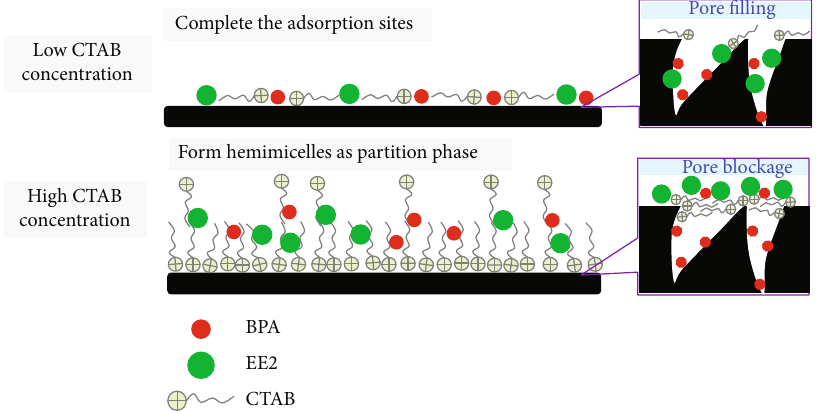
Figure 6: Schematic graph of mechanisms controlling the e ff ects of CTAB